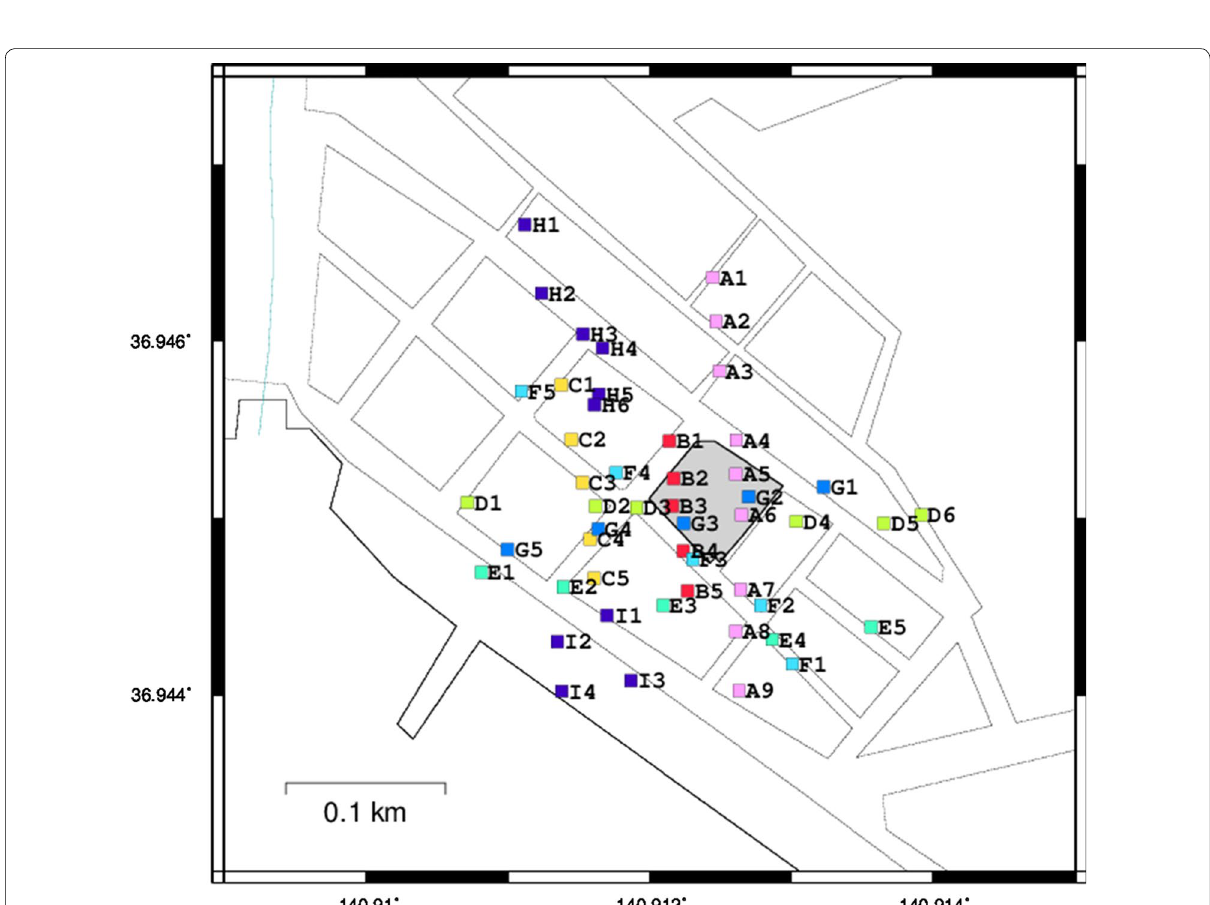
Fig. 3 The microtremor observation points outside of the premises of the Onahama Port Office for Line-A to Line-I. The dotted lines are local roads picked originally from general maps. The gray hatched block surrounded by thicker lines denotes the premises of the Onahama Port Office shown in Fig.